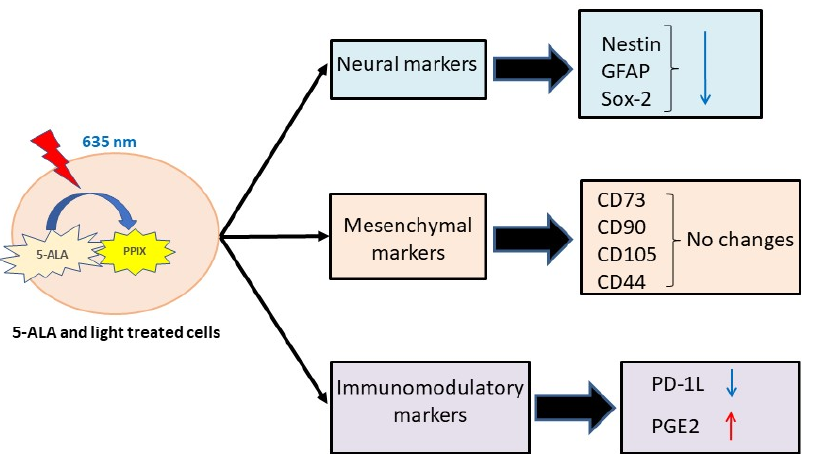
Figure 9. The summary of the results obtained for the effect of PDT on GB-MSCs. The PDT leads to the down-regulation of markers associated predominantly with neural differentiation (Nestin, Sox-2, and GFAP). The markers associated predominantly with the mesenchymal phenotype (CD73, CD90, CD105, and CD44) retain their expression. According to the substances engaged with immunomodulation, PD-1L decreases its expression, but PGE2 demonstrates elevated secretion levels.